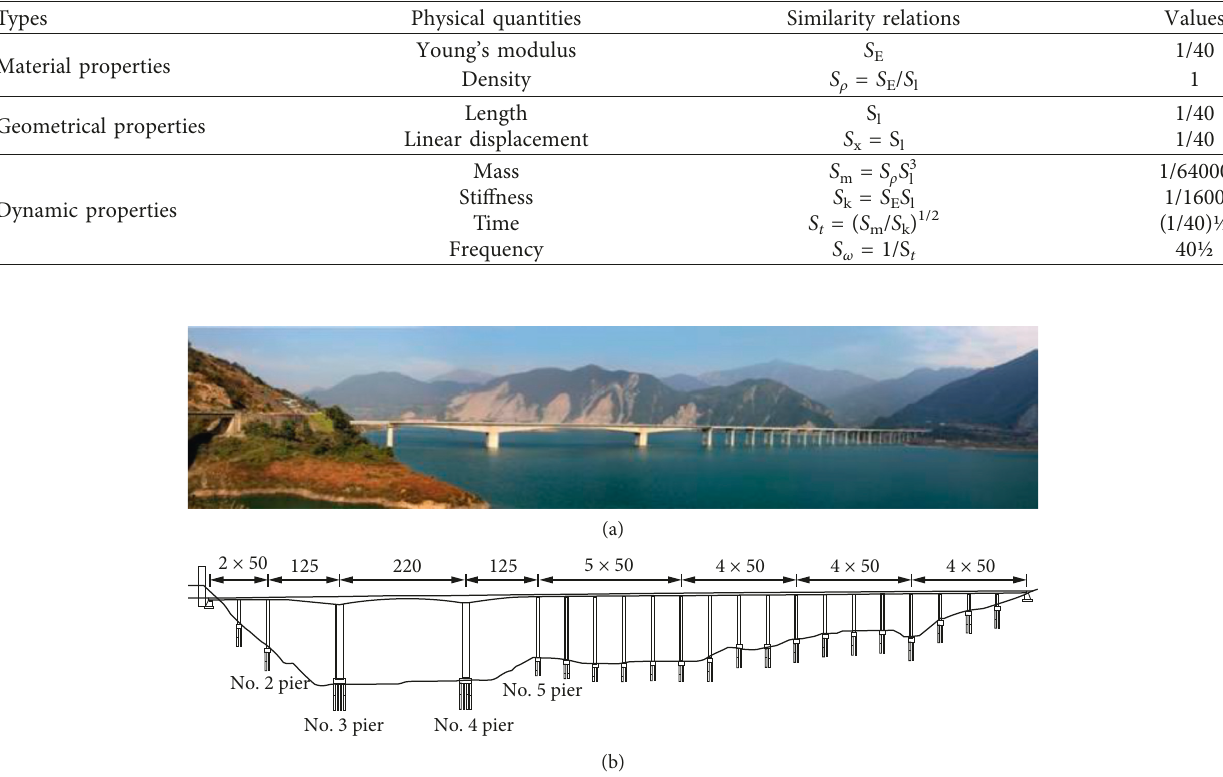
Figure 1: General layout of the Miaoziping Bridge; all dimensions are in meters. (a) Picture of the Miaoziping Bridge. (b) Elevation view.